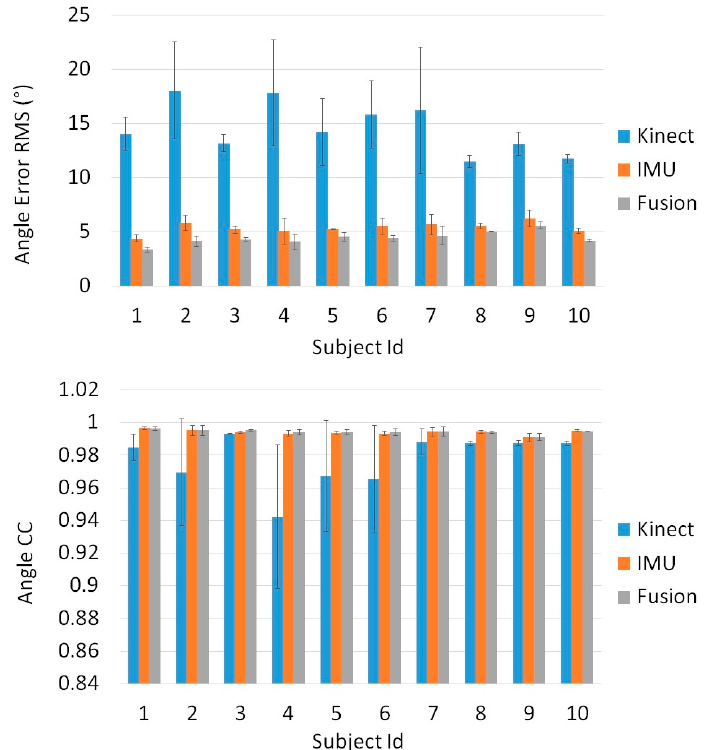
Figure 6. Angle error RMS (°) and angle Correlation Coefficient calculated for the Kinect, IMU and the proposed fusion algorithm Vs the universal goniometer, when IMU sensors are placed in the frontal plane position.